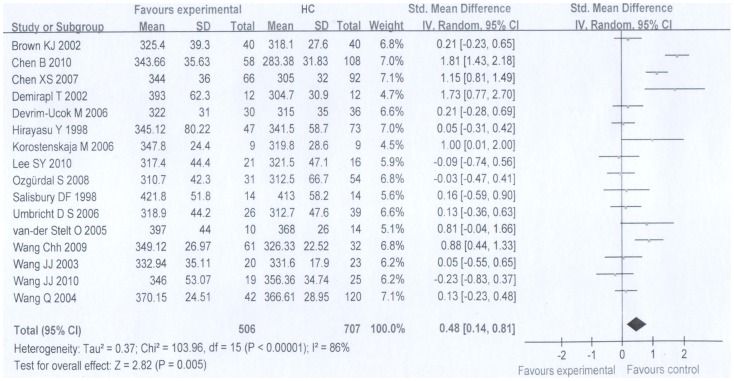
Meta-analysis on the forest map of P300 latency of FES group and HC group.